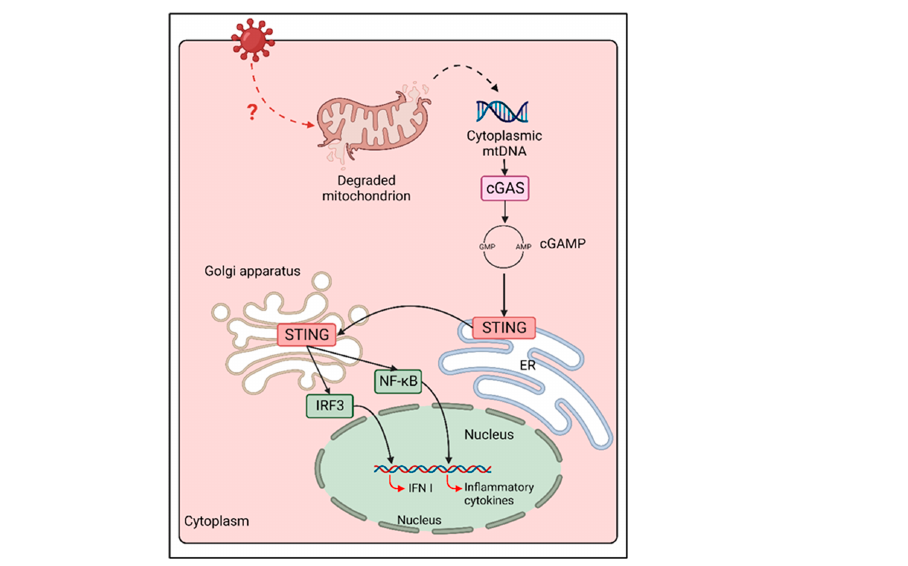
Figure 2. cGAS/STING activation following MeV infection. Following MeV infection, an unknown cellular mechanism induces mitochondrial stress and mitochondrial membrane degradation. mtDNA is than released in cytoplasm, where it is sensed by cGAS, triggering cGAMP synthesis and STING activation. STING translocation from ER to Golgi and perinuclear puncta coincides with the activation of both NF- κ B and IRF-3, thus enhancing the expression of inflammatory cyto- kines and type I IFN during MeV infection.